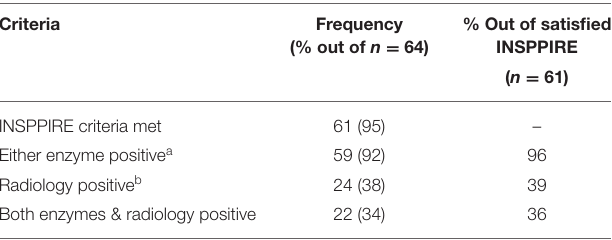
TABLE 4 | Adherence to diagnostic criteria, and contribution of enzymes and radiology to